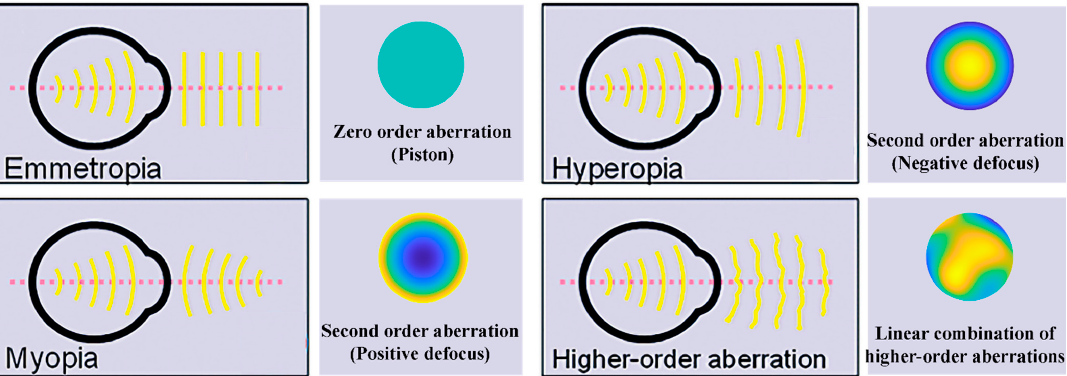
Figure 1. Scheme of wavefronts and corresponding contour maps for different cases. Teal color indicates no deviations; colors towards yellow indicate positive deviations, while those towards blue indicate negative deviations. Therefore, in the case of the myopic eye (bottom-left panel) the wavefront is represented by a paraboloid with the minimum in the center and the maximum at the edge. The contrary happens in the case of the hyperopic eye (top-right panel): the paraboloid is turned upside down with the maximum in the center and the minimum at the edges. Figure adapted with permission from Wiley from Ref. [3] Naoyuki Maeda, Clinical applications of wavefront aberrometry—a review, Clinical & Experimental Ophthalmology , 37: 118–129. © 2009 Royal Australian and New Zealand College of Ophthalmologists.